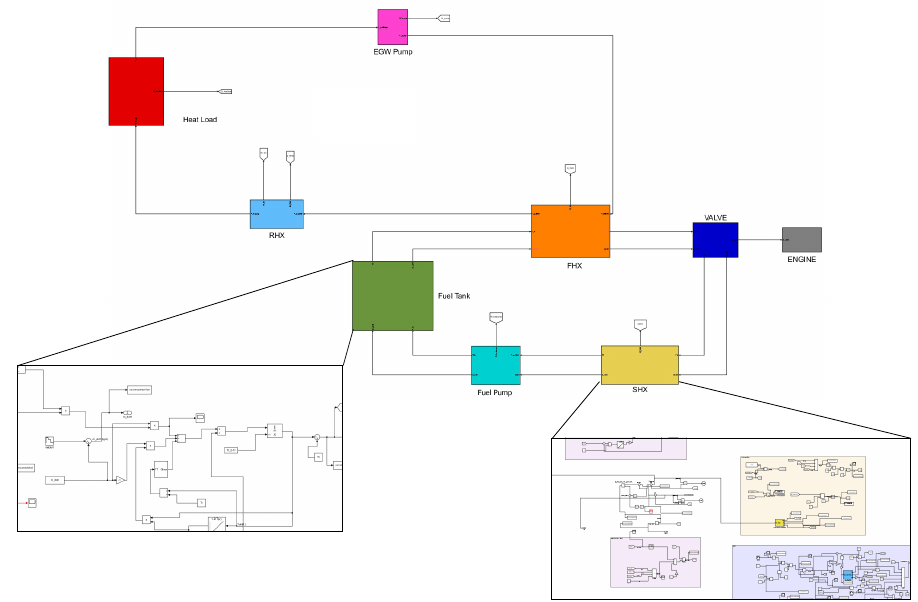
Figure 6. Architecture 5 blocks